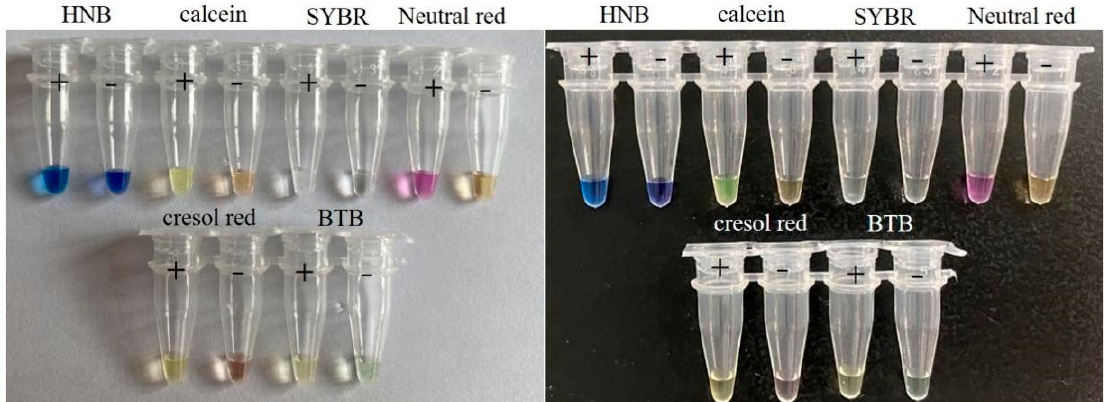
Figure 3, the neutral red presented the sharpest color change running from light orange to pink. Here, pink indicated a positive reaction while the negative remained light orange. The results of cresol red (yellow to light pink), HNB (sky blue to violet), calcein (yellow-green to yellow), SYBR green I (light yellow to achromatic color), and BTB (light green to light yellow) were all more or less relative difficult to be distinguished by naked eyes because of less difference of the color change between the positive and negative reactions.